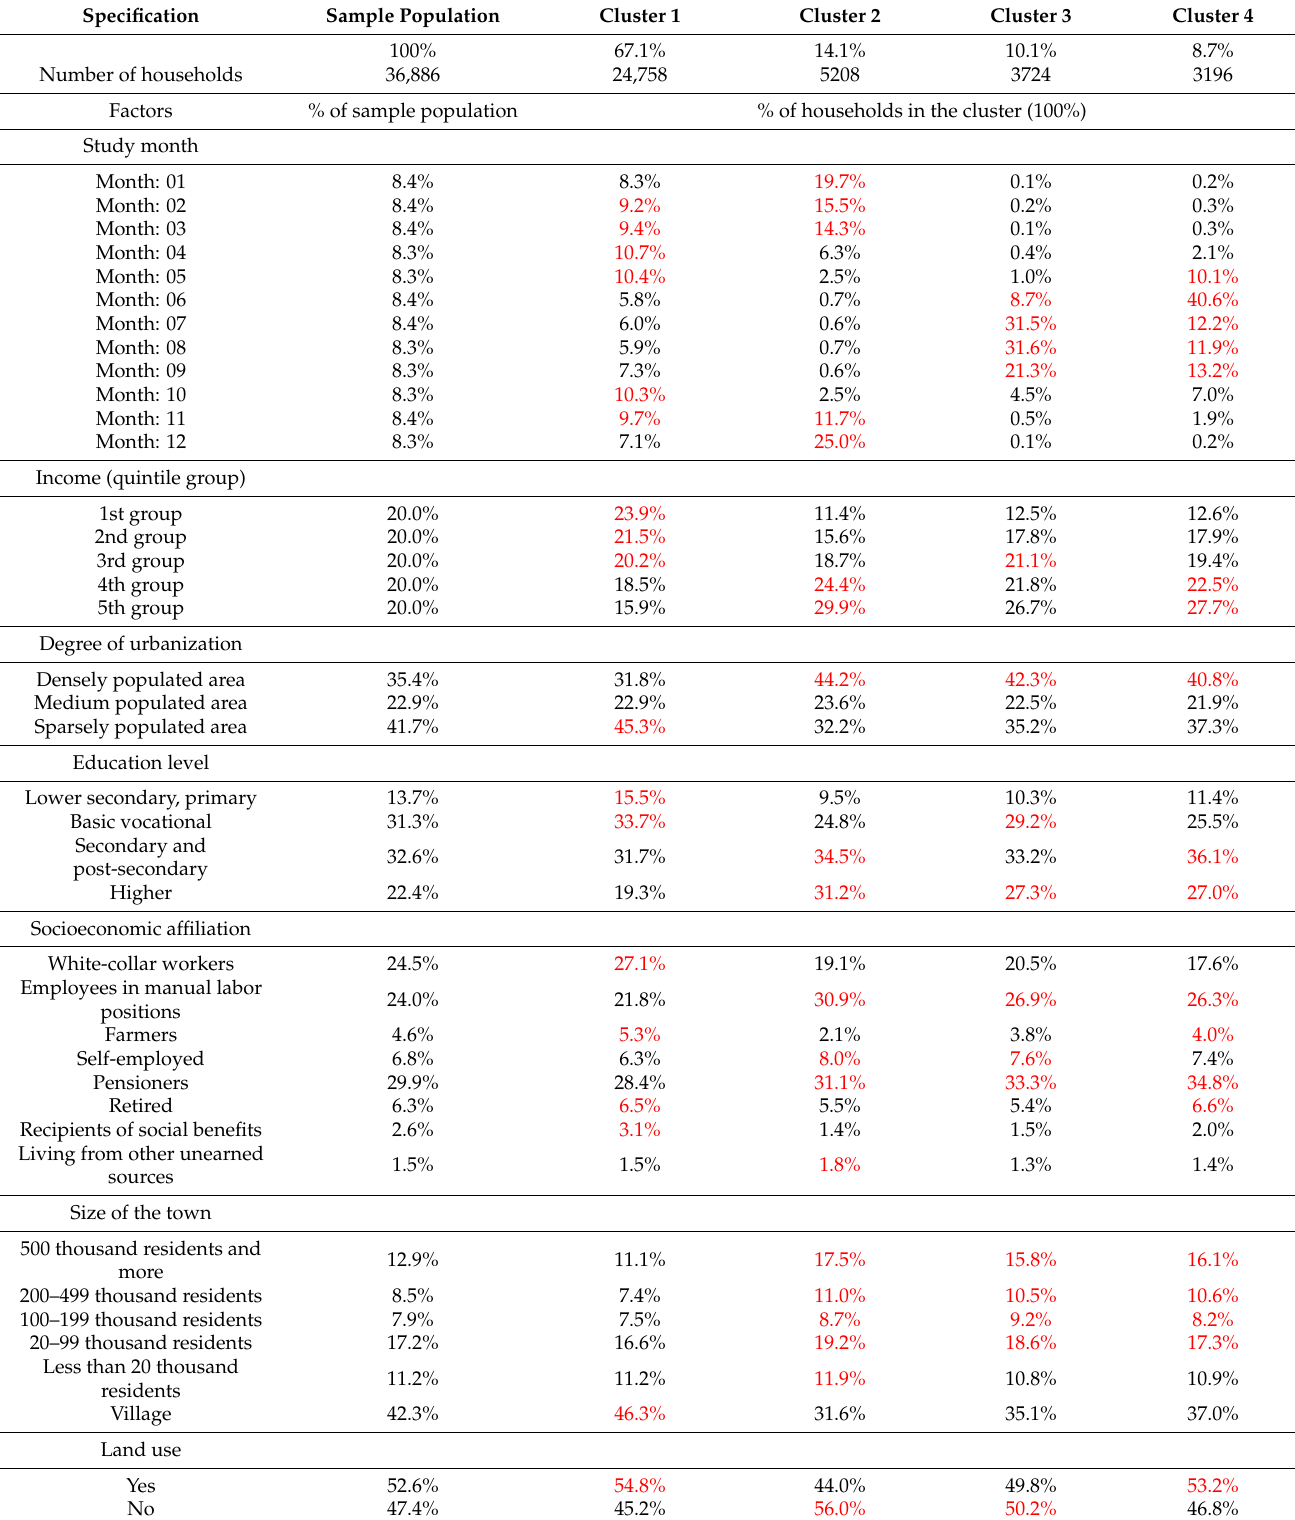
Table 5. Cluster analysis: characterization of clusters in terms of designated socioeconomic